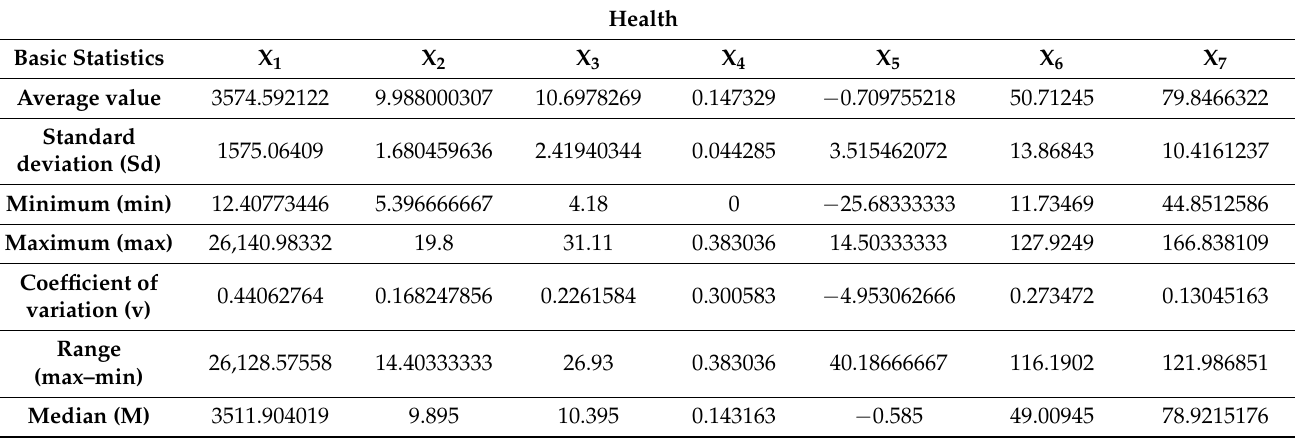
Table 3. Main characteristics of empirical variables describing the human capital in area of health.